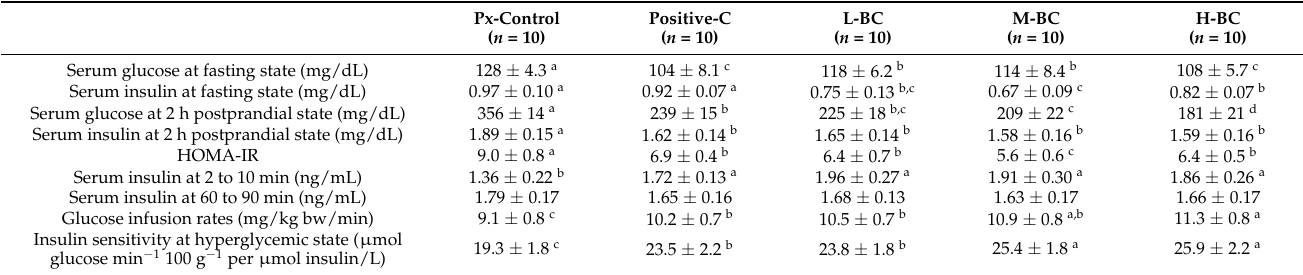
Table 2. Serum glucose and insulin concentrations, glucose infusion rats, and insulin sensitivity during the hyper- glycemic